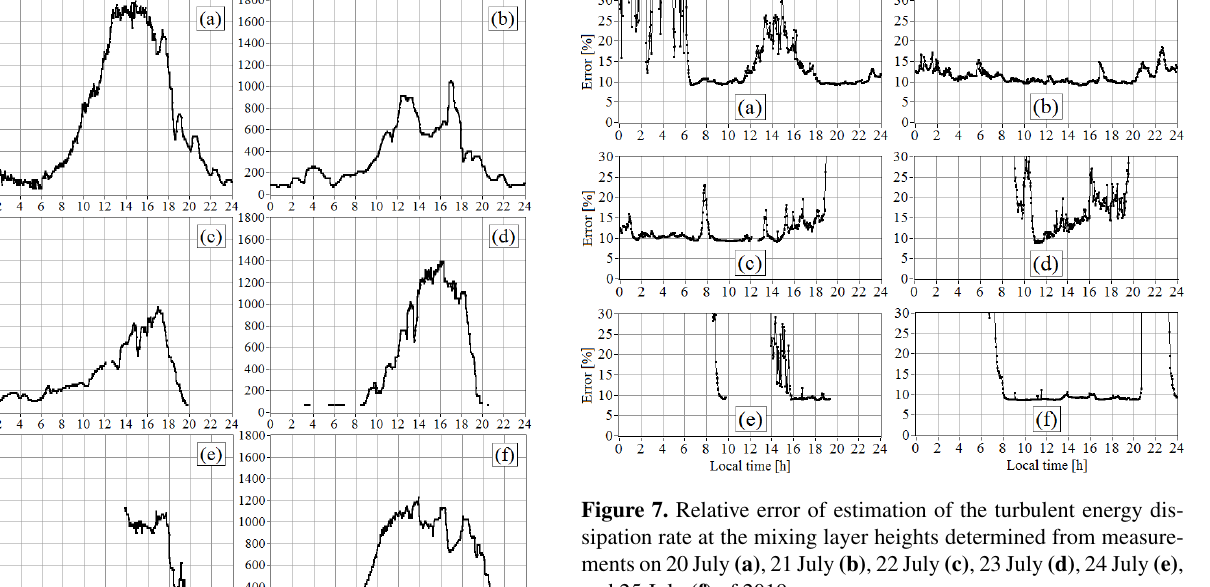
true dissipation rate) were calculated with the use of the dis- tributions of the dissipation rate ε(h k ,t n (cid:48) ) and the instru-